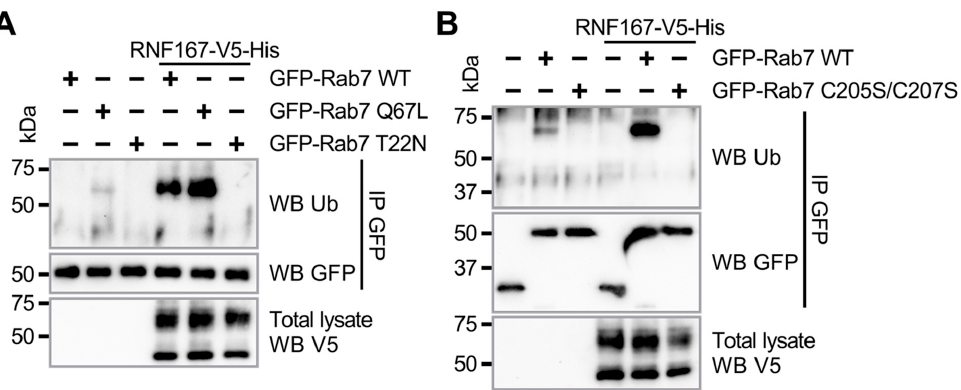
Figure 3. RNF167-mediated ubiquitination of Rab7 requires GTPase activity and association with the membrane . ( A , B ) HEK293T cells were transfected with plasmids encoding the indicated proteins, and cells were lysed before immunoprecipitation with a GFP antibody. Immunoblot with UB antibody following immunoprecipitation evaluated Rab7 ubiquitination. ( A ) Rab7 ubiquitination requires GTPase activity. ( B ) Rab7 ubiquitination requires its membrane anchoring. Blots are representative results of two independent experiments.